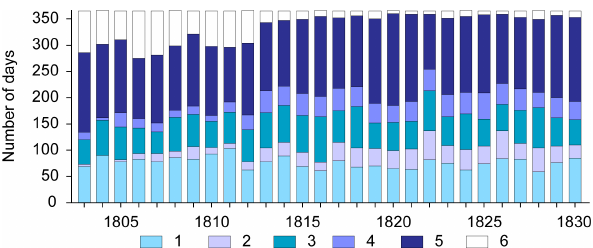
Figure 7. Fluctuations in annual cloudiness at Buchlovice during 1803–1830 derived from the weather diary kept by Šimon Hausner: (1) clear sky, (2) clear sky in one part of the day and half-covered sky in the other part, (3) half-covered sky, (4) half-covered sky in one part of the day and overcast in the other part, (5) overcast, and (6) missing days or no information related to